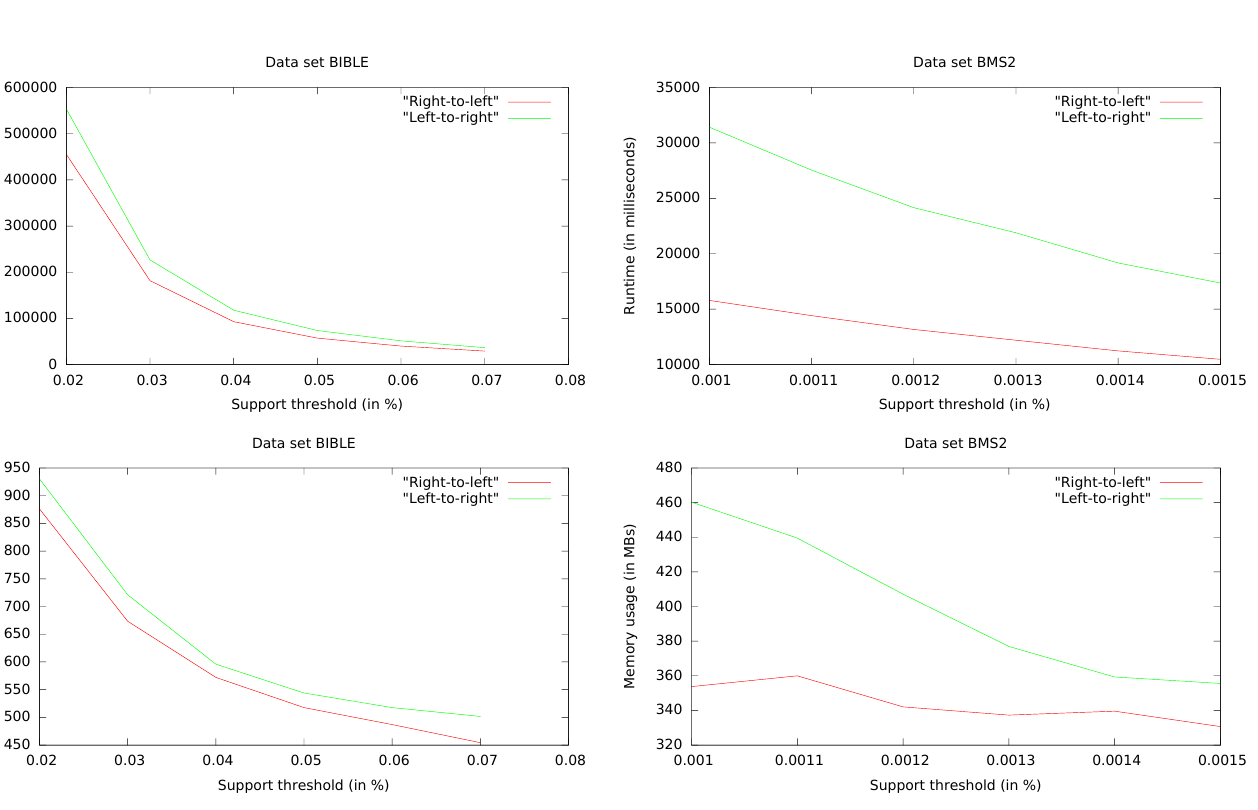
Figure 4. Performances of left-to-right and right-to-left pattern- growth orderings on the real-life data set BMS2. The right-to- left pattern-growth ordering is 1 . 5 − 2 times faster and requires almost 1 . 07 − 1 . 3 times less memory than the other